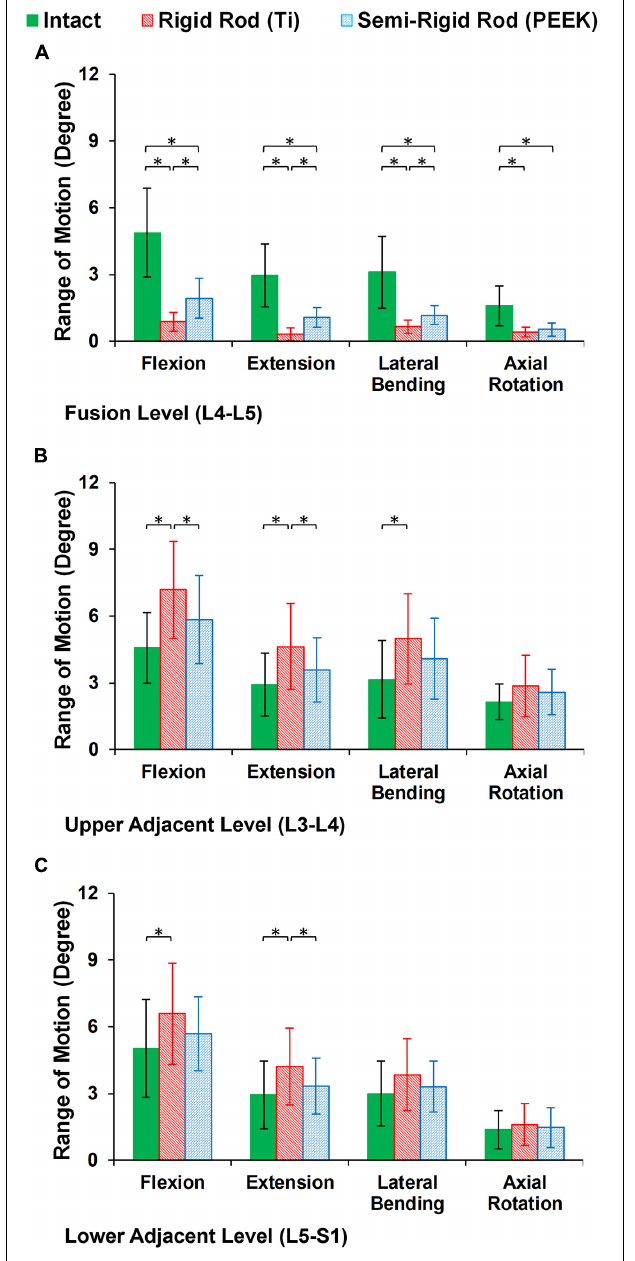
FIGURE 7 | Intersegmental range of motions (ROMs) for postoperative FE models in the (A) instrumented level (L4–L5), (B) upper adjacent level (L3–L4), and (C) lower adjacent level (L5–S1). The error bars indicate the standard deviations, and “ ∗ ” shows that p values < 0.05.